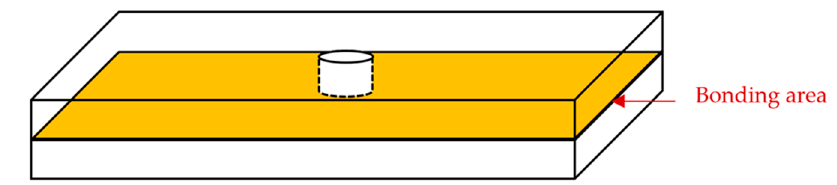
Figure 11. Schematic diagram of specimen for gas tightness test.